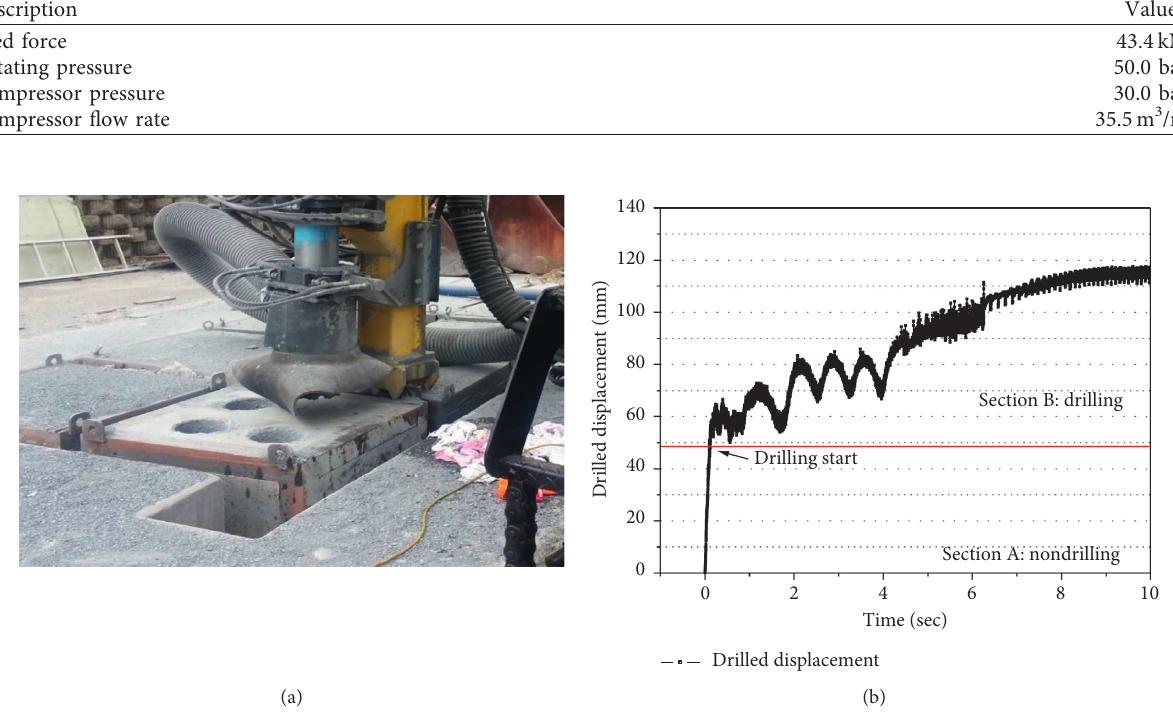
Figure 16: Results of the in situ drilling test: (a) concrete mass being drilled and (b) the measured drilled